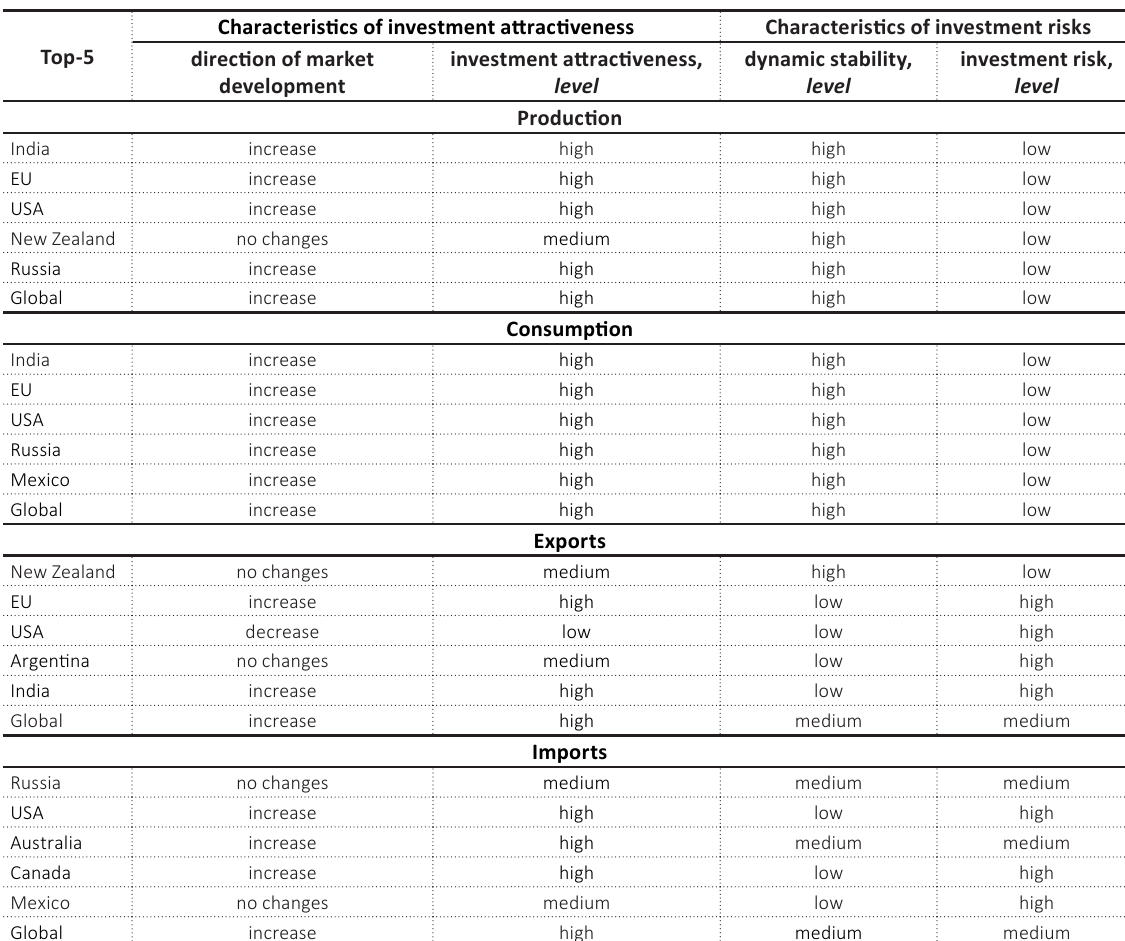
Table 5. Investment attractiveness and risks of investing in the global butter market